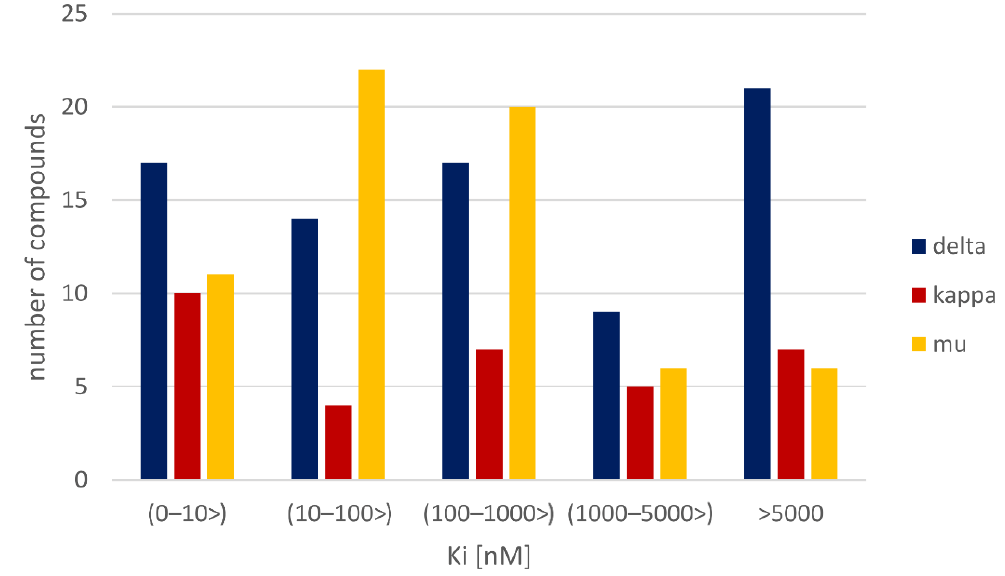
Figure 5. K i distribution for compounds with the highest prediction error common for all methods used.